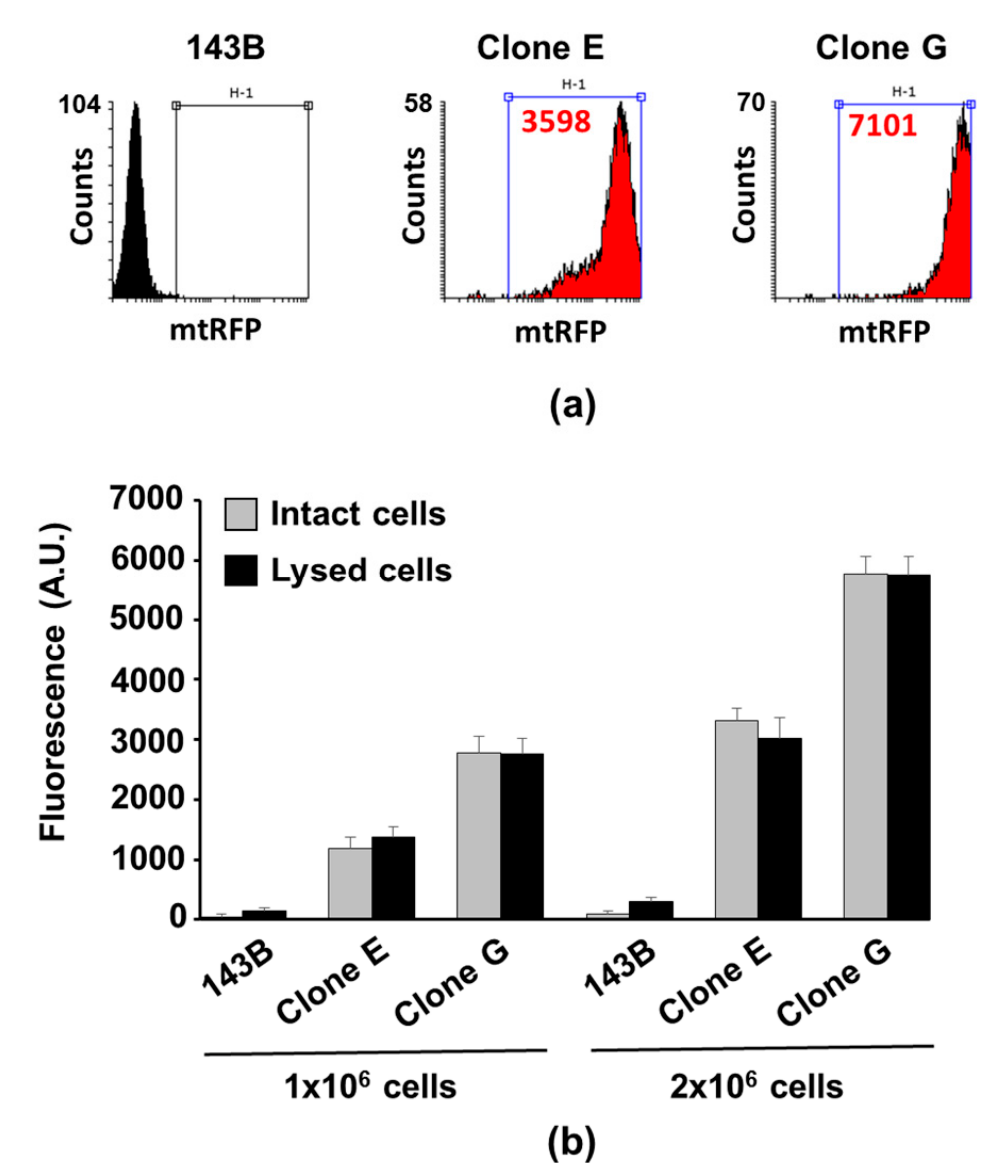
Figure 3. mtRFP fluorescence intensity and mitochondria mass are directly related. ( a ) Cell fluorescence distribution of both 143B parental cells and derived mtRFP clones (143B-Clone E and the 143B-Clone G); the mean fluorescence intensity of H1-gated population is indicated in red. ( b ) Fluorometric measurements of two di ff erent amounts of intact and lysed